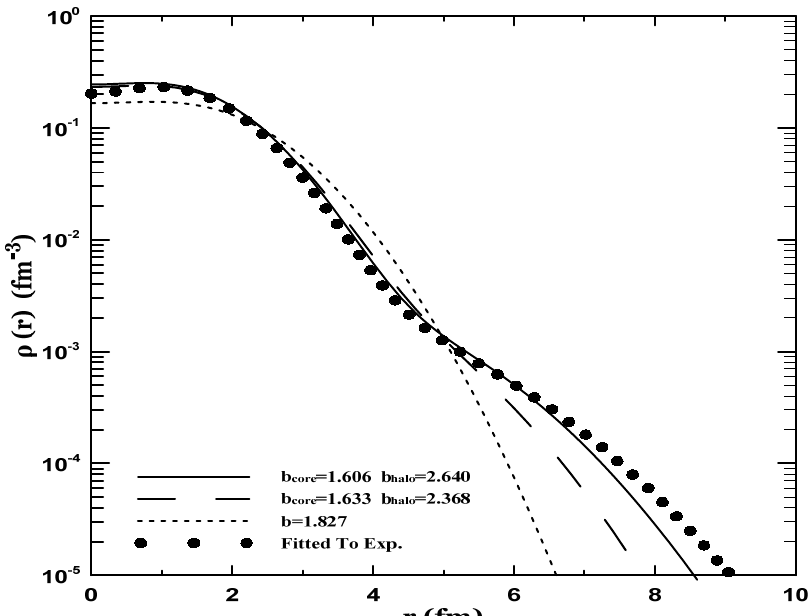
Fig. 2: The calculated ground state matter densities of 17 Ne nucleus with one size parameter value (dotted curve) and with 15 O core-two protons in 1d orbit (dashed and solid curves, respectively). The 5/2 filled circles are the experimental data extracted from Glauber model [30].